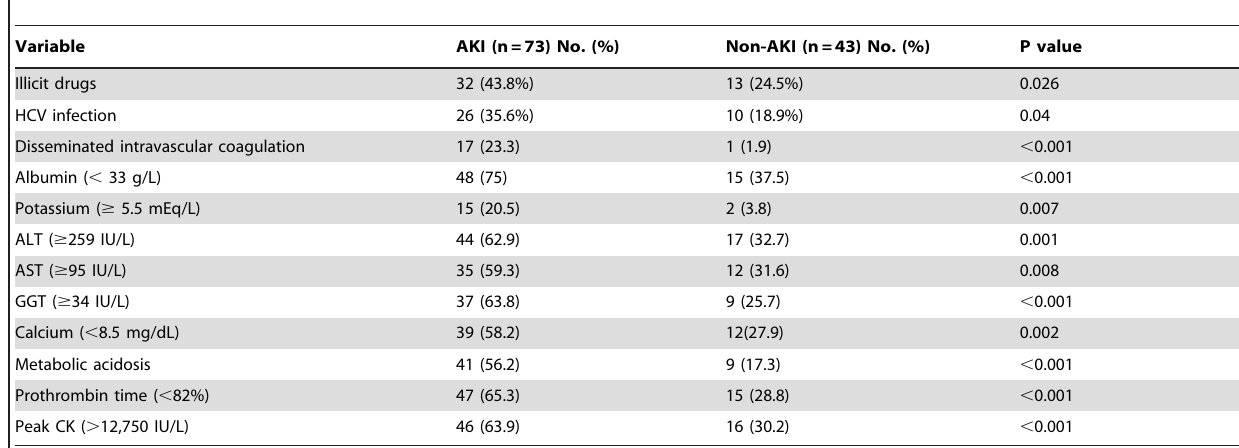
Table 2. Comparison of clinical characteristics and peak laboratory values between patients with severe rhabdomyolysis with or without